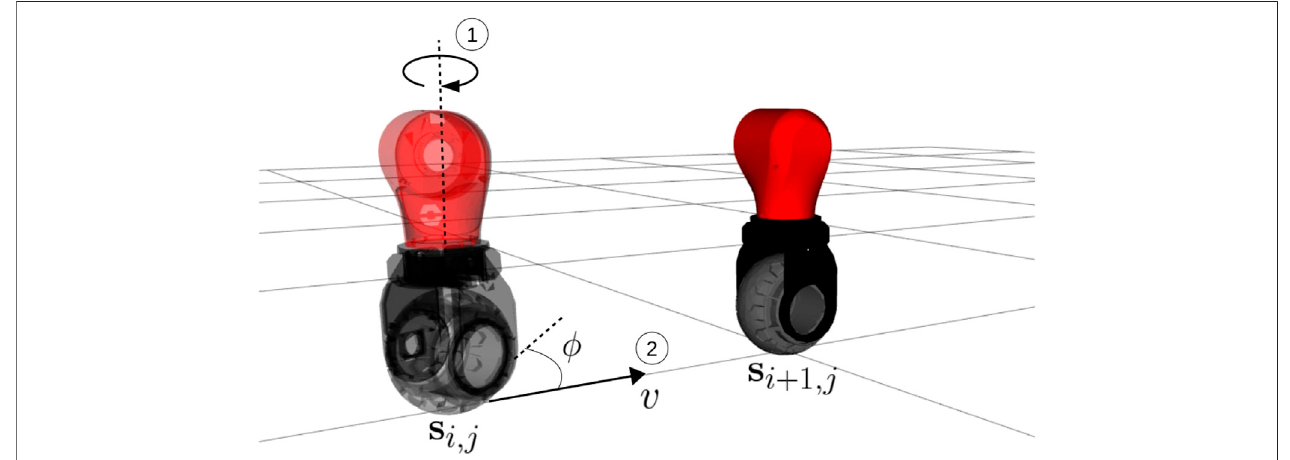
FIGURE10| Agraphicalrepresentationofthewheelcontrollogic.First, the j th wheel ∈ s i isorientedinthedirectionofthenextstate s i + 1 , j throughananklerotation, and then the wheel rolls toward the next state position.